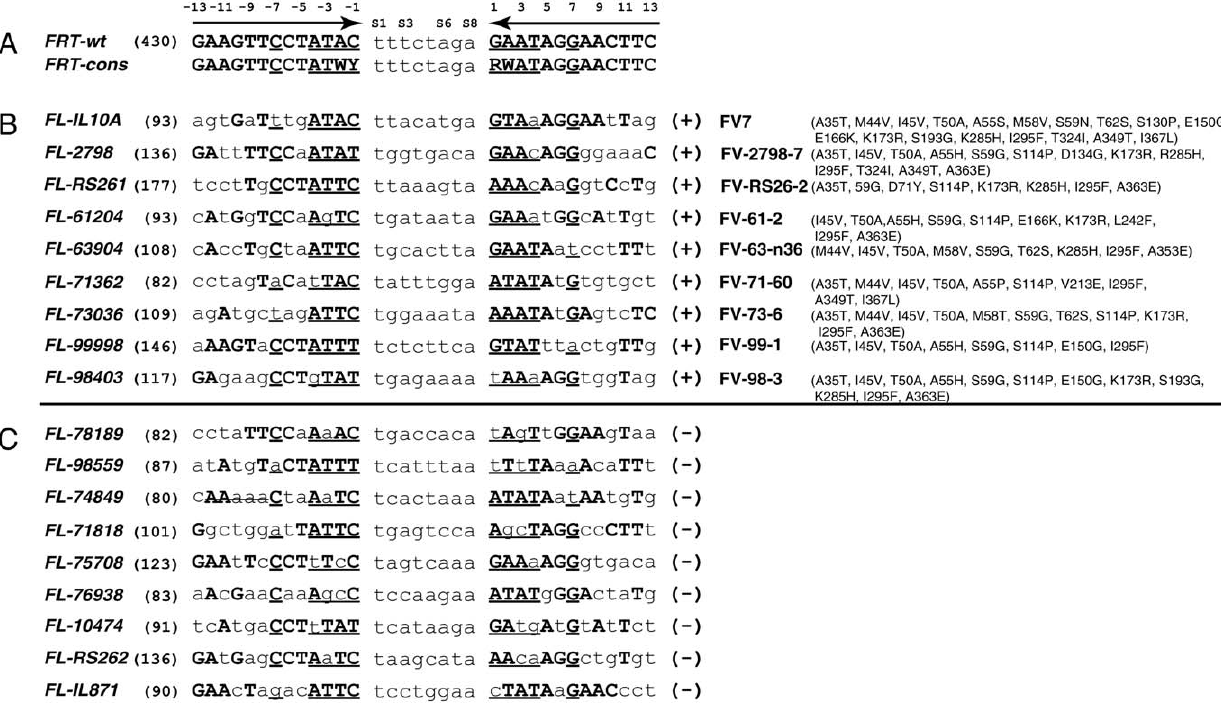
Figure 1. FRT (A), successful FRT -like sequences (B) and unsuccessful FRT -like sequences (C). FRT -wt = wild-type FRT ; FRT -cons = consensus FRT sequence that reflects nucleotide changes known to be tolerated by Flp variants. FRT -cons served as a query to scan the human genomic sequences to identify FRT -like sequences. FRT -like sequences FL-IL10A, FL-2798 and FL-IL871 are from the human interleukin-10 gene; FL- RS261 and FL-RS262 are from human ROSA26 locus; FL-61204 , FL-63904 , FL-71362 , FL-71818 , FL-73036 , FL-74849 , FL-75708 , FL-76938 and FL-78189 are from the human beta-globin gene; FL-98403 and FL-99998 are from mouse Rosa26 locus; FL-10474 is from the mouse tyrosinase gene. Numbers in brackets indicate the scores the FRT -like sequences have according to the program TargetFinder [14]. Flp variants able to recombine the respective FRT -like sequences with at least 10% efficiency are shown next to the successful FRT -like sequences. Flp variant FV7 able to recombine FL-IL10A was reported earlier